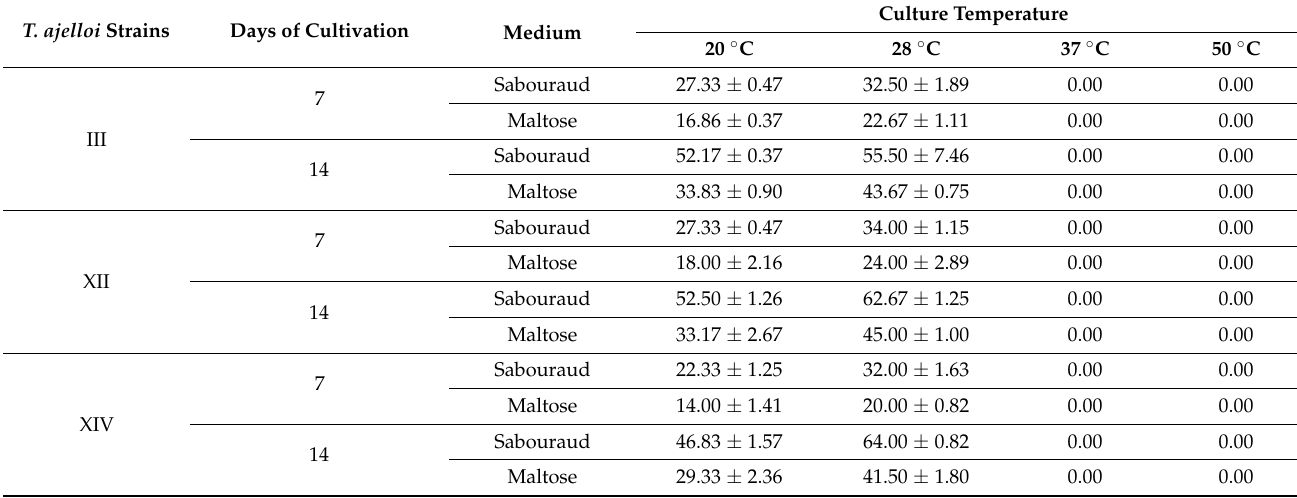
Table 1. Size of colony diameter [mm] of Trichophyton ajelloi